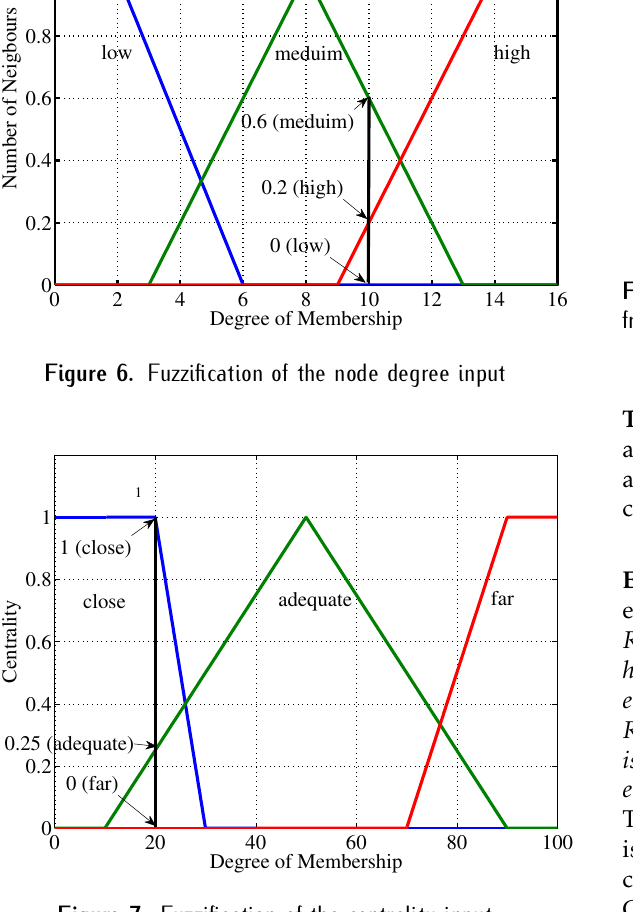
Figure 7. Fuzzification of the centrality input